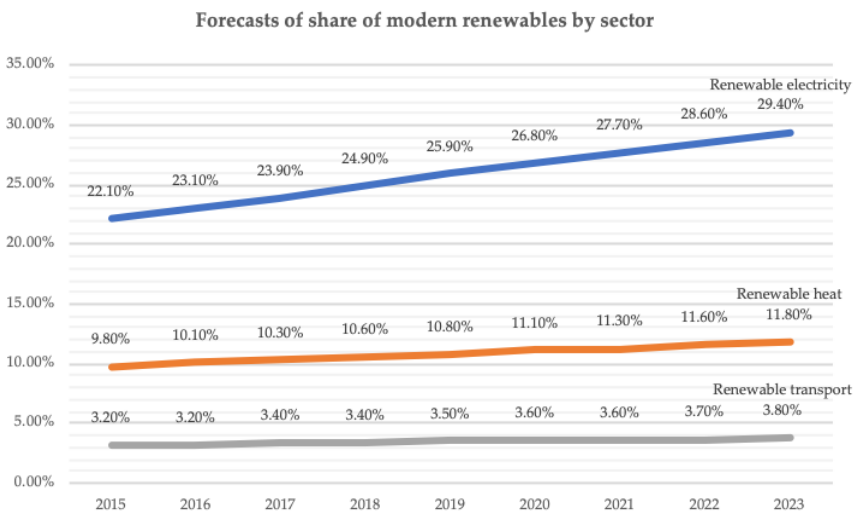
Figure 16. Forecasts of the share of modern renewables by sector (Source: IEA).